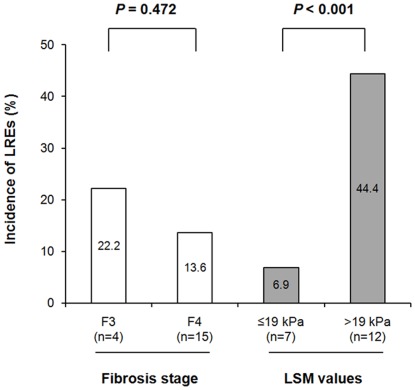
Incidence of LREs according to fibrosis stage and LSM values.The incidence of LREs was similar between patients with F3 fibrosis stage and those with F4 (22.2% vs. 13.6%, P = 0.472) whereas it was signficanly different between patients with LSM value ≤19 kPa and those with LSM value >19 kPa (6.9% vs. 44.4%, P<0.001). LRE, liver-related event; LSM, liver stiffness measurement; kPa, kilopascal.